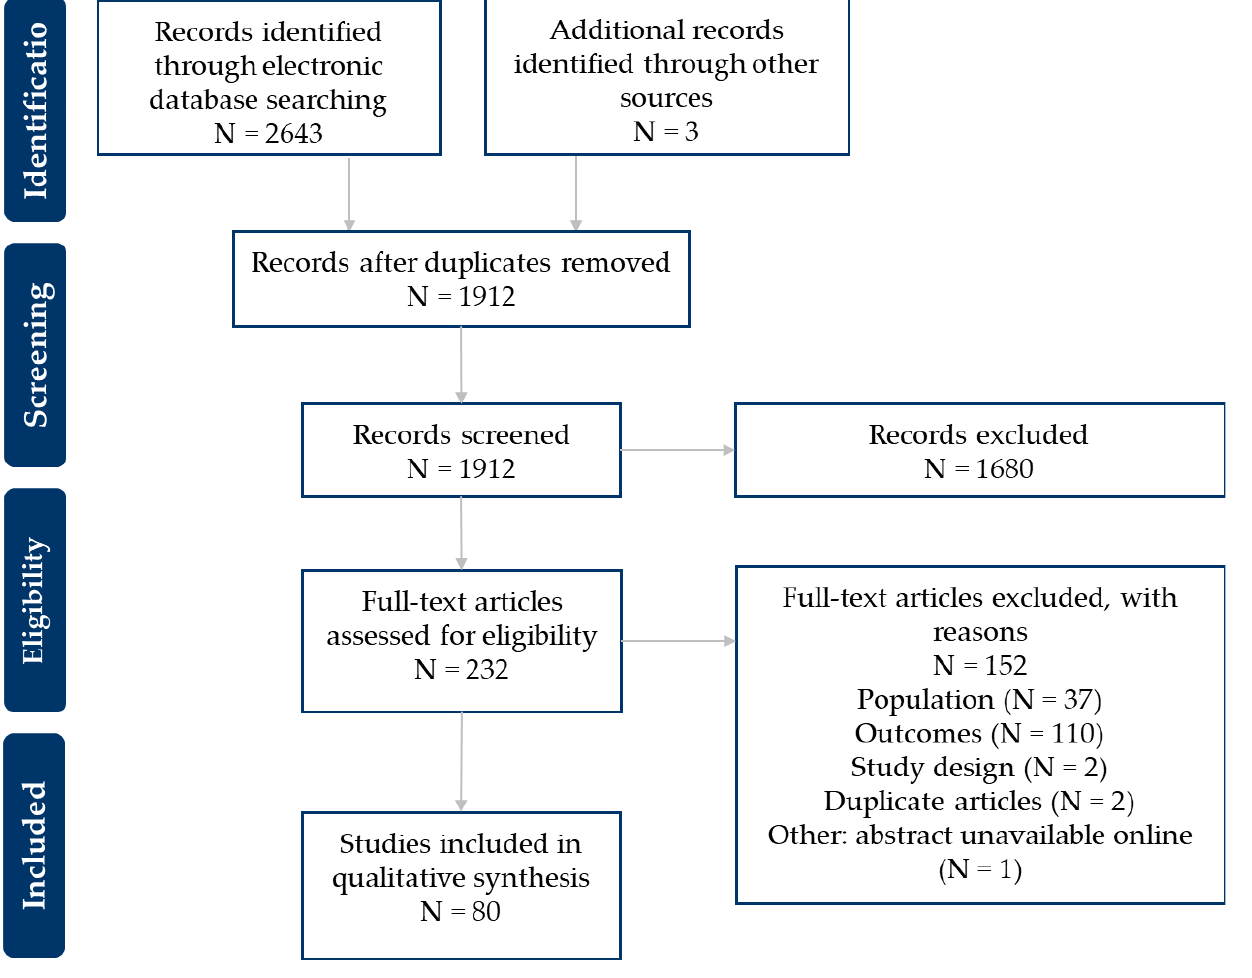
Figure 1. PRISMA flowchart of publications included in the review.